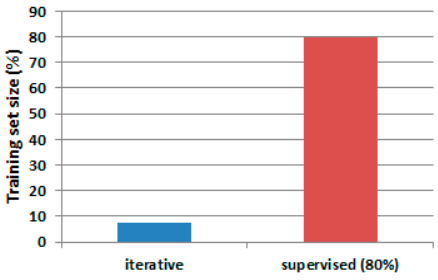
Figure 7. Training size comparison.